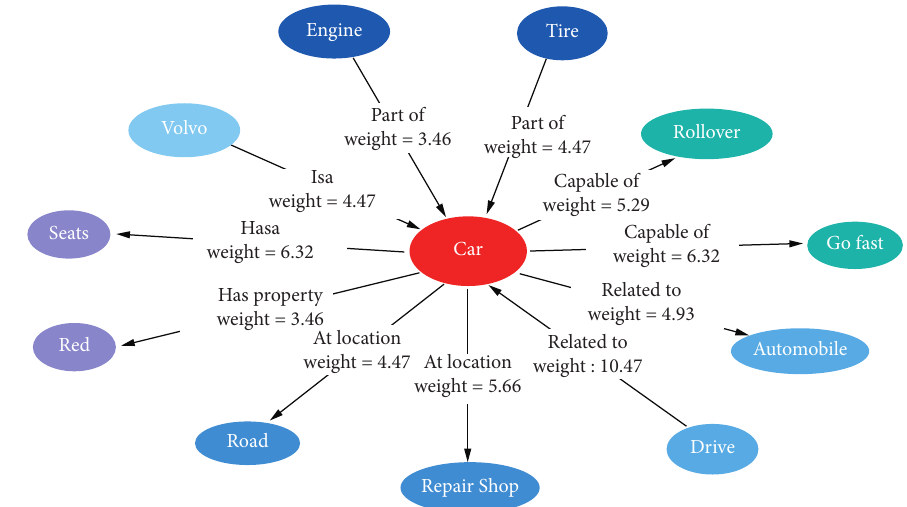
Figure 3: A simple illustration of